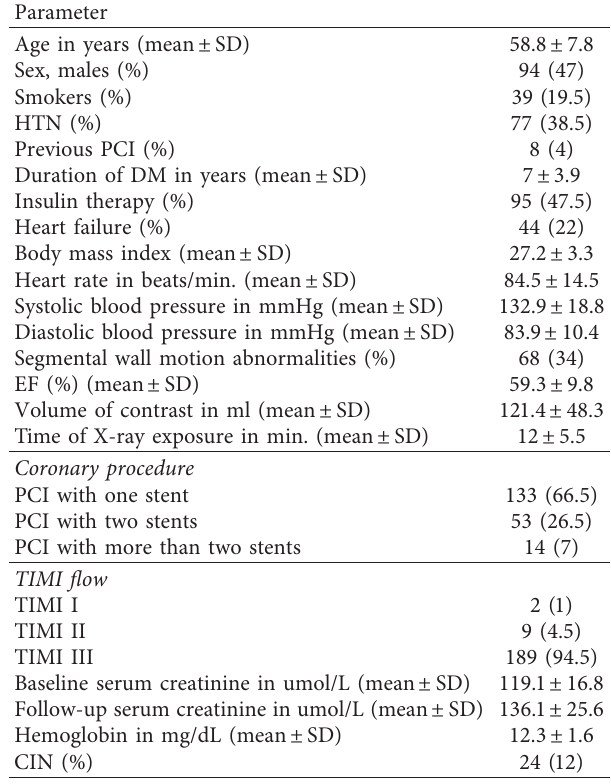
Table 1: The baseline demographic, clinical, echocardiographic, and laboratory data of the studied